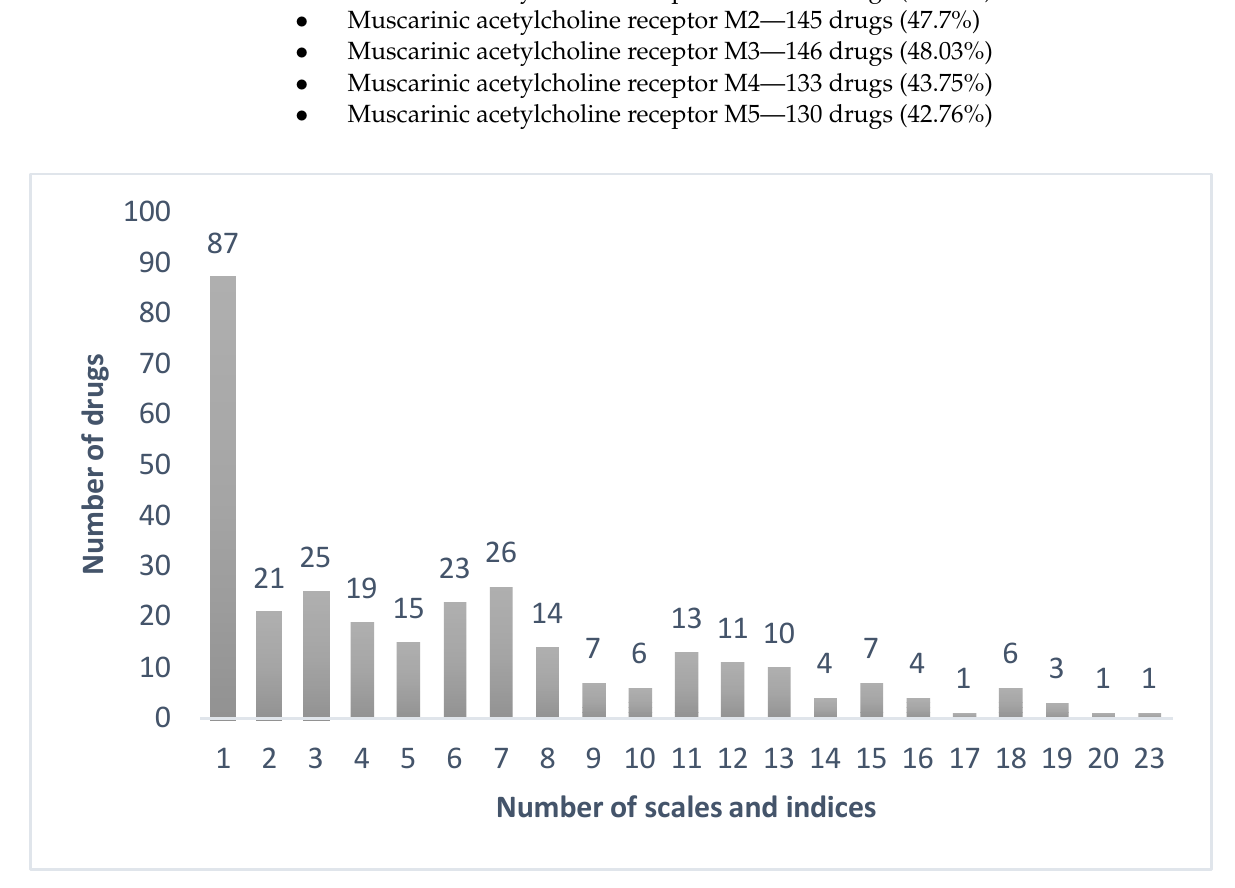
Figure 1. Distribution of the number of drugs according to the number of anticholinergic burden tools. Table 1. Percentage of drugs identified by each database regarding their affinity for each of the muscarinic receptor